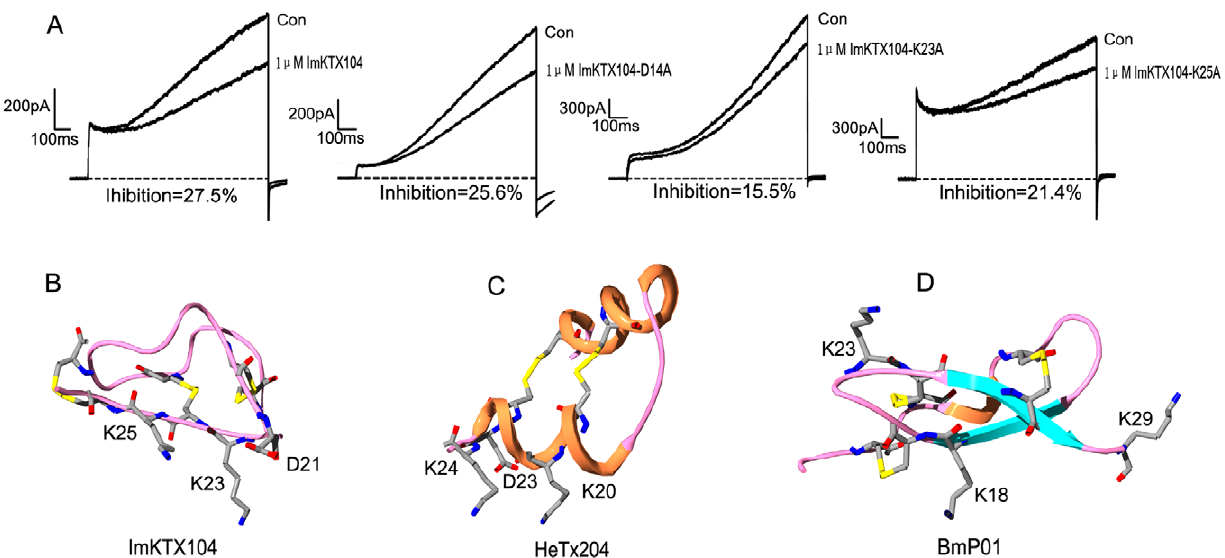
Figure 9. Structure-function relationships of acidic KTxs. (A) The effect of ImKTx104 mutants on KCNQ1 channel current, and Average inhibition is indicated (n . 3); (B–D) Possible binding interfaces of ImKTx104, HeTx204, and BmP01, respectively.